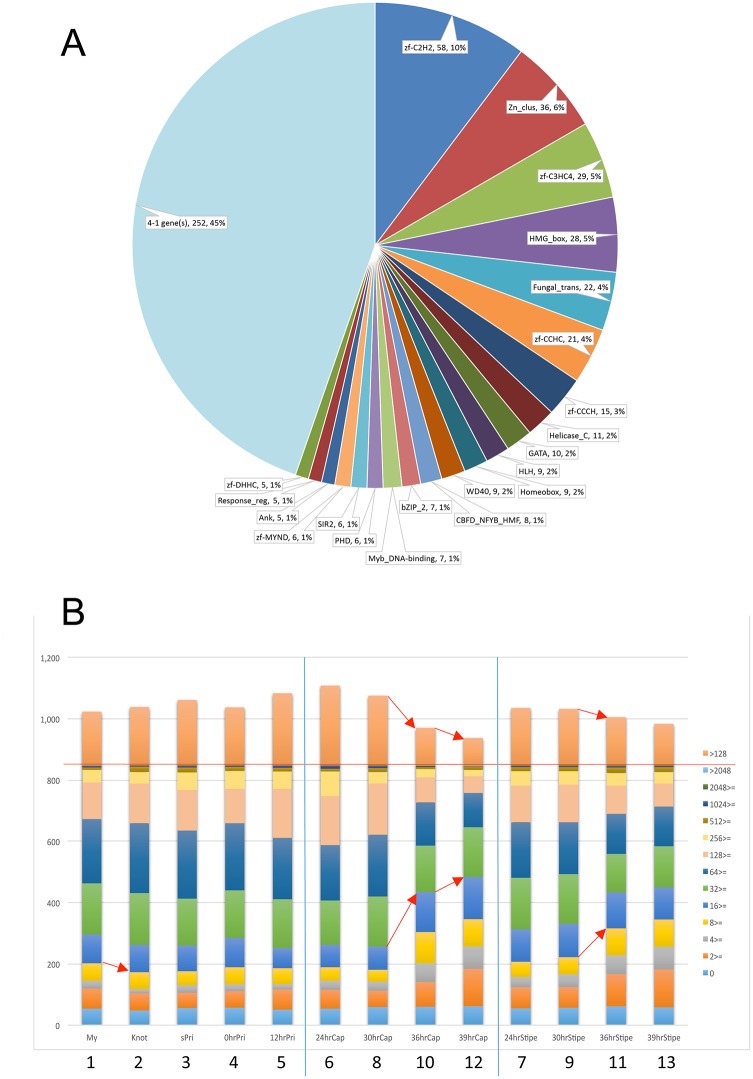
Transcription factor candidates in C. cinerea and changes in the expression levels.(A) Relative distribution of Pfam domains in the TFCs. A total of 848 TFCs were sorted on the basis of Pfam domains, and the number and percentage of each Pfam are indicated. (B) A histogram dividing 848 transcription factor candidates into bins based on their RPKM values. Red line shows a total number of the TFC genes, 848. Red arrows indicate notable changes.